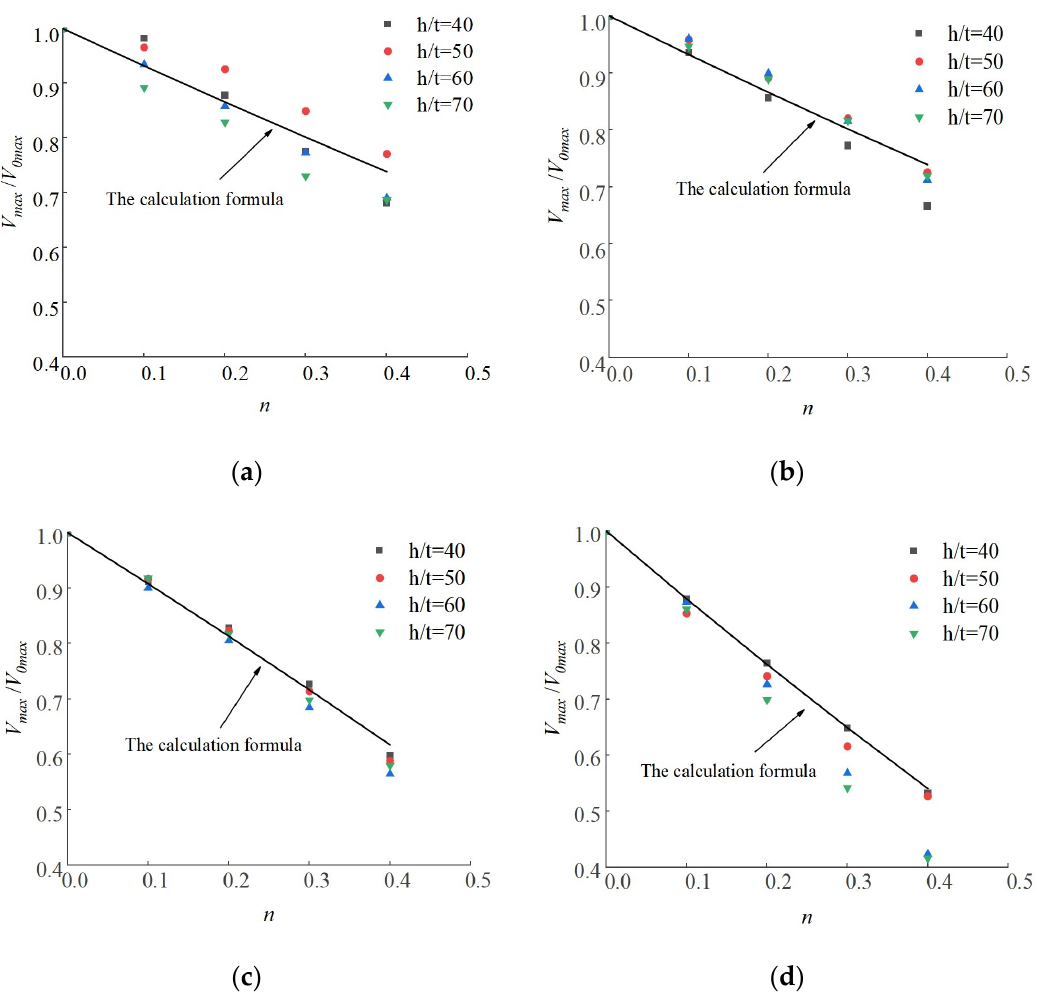
Figure 17. The effect of n on V max / V 0max . (a) λ = 15; (b) λ = 30; (c) λ = 50; (d) λ = 70.